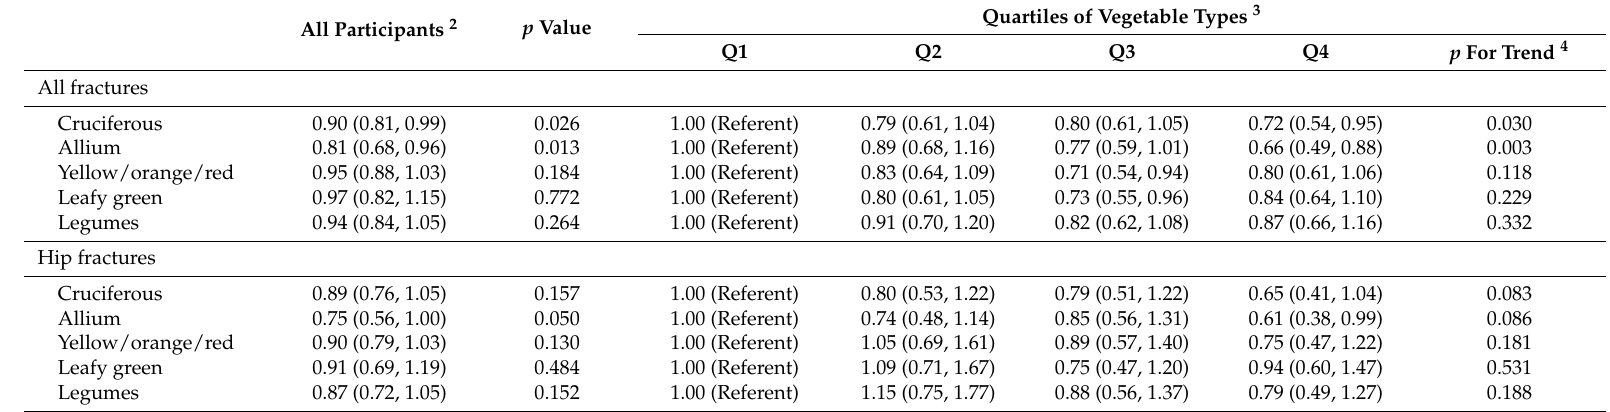
Table 4. Multivariable-adjusted hazard ratios for fracture-related hospitalisation by vegetable type 1